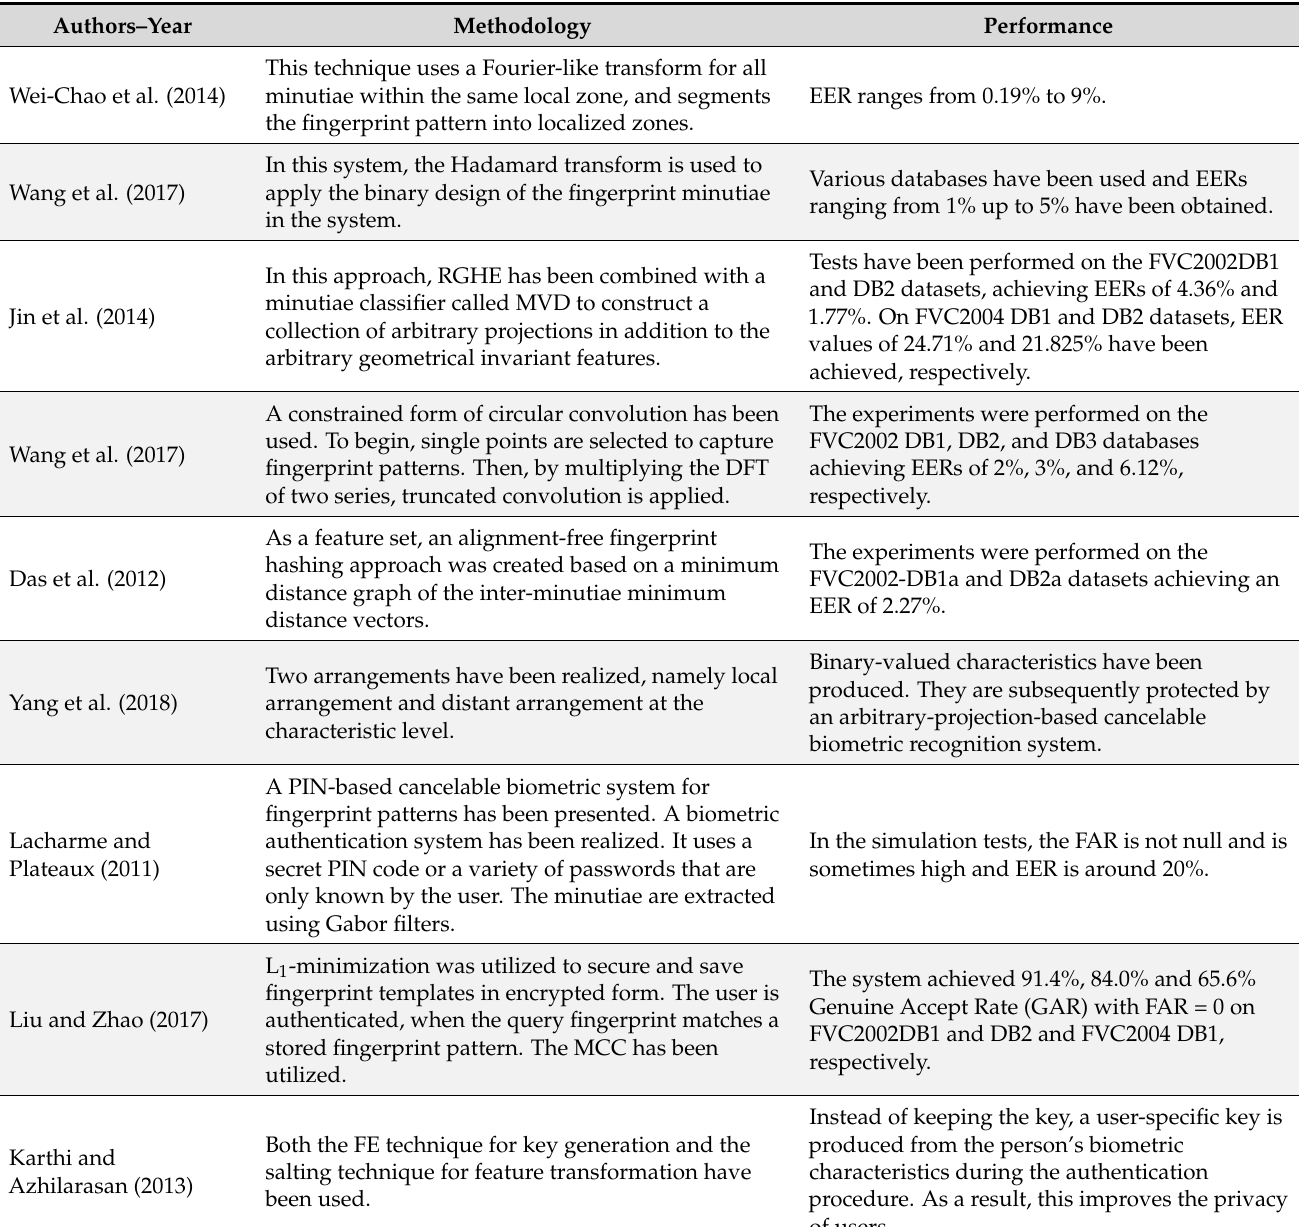
Table 1. Comparison of the characteristics of related